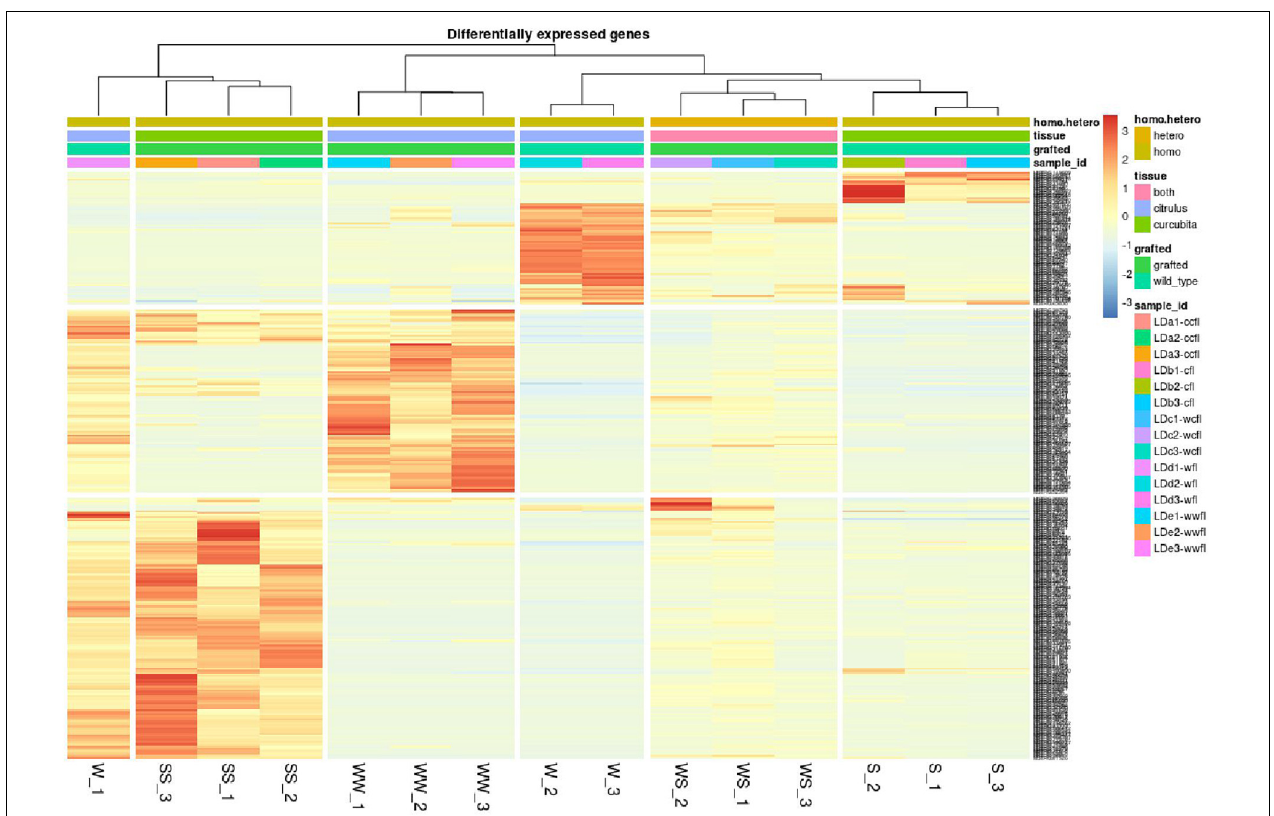
FIGURE 5 | Heatmap of differentially expressed genes (DEGs) of grafted plants (WW, SS, an WS) vs. non-grafted controls (W, S). The heatmaps depict genes with p < 0.05 and fold change > 4. The color scale (blue to red) represents the expression levels in